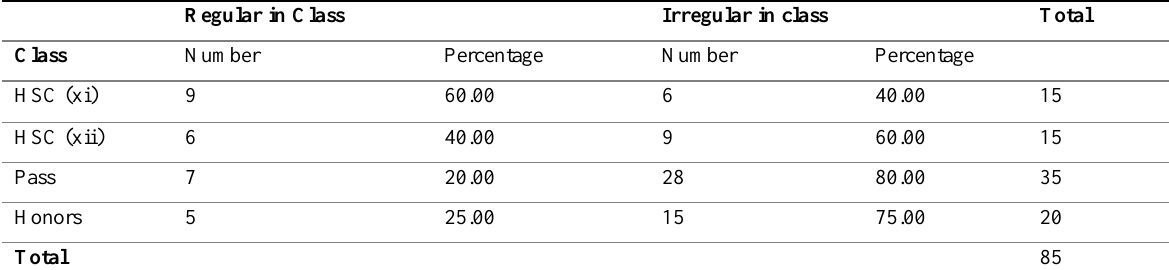
Table 2: Attendance in College-B (5% of total students)